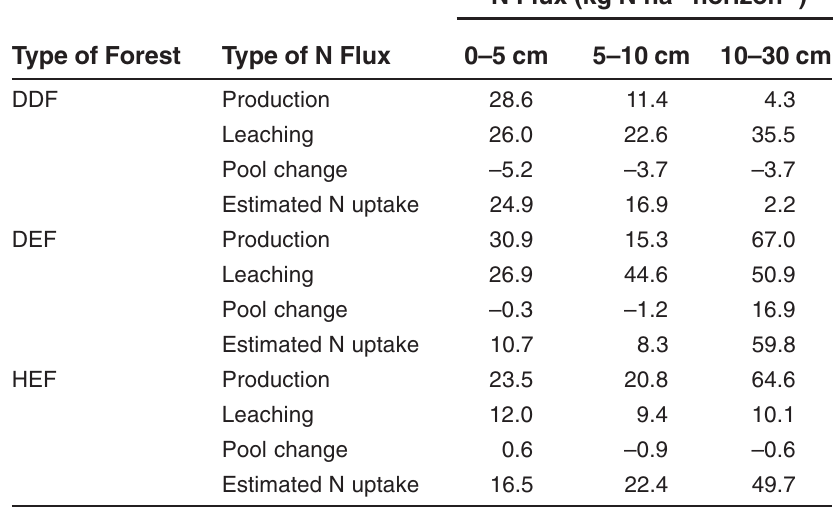
Vertical Change of N Fluxes in Three Contrasting Dry Tropical